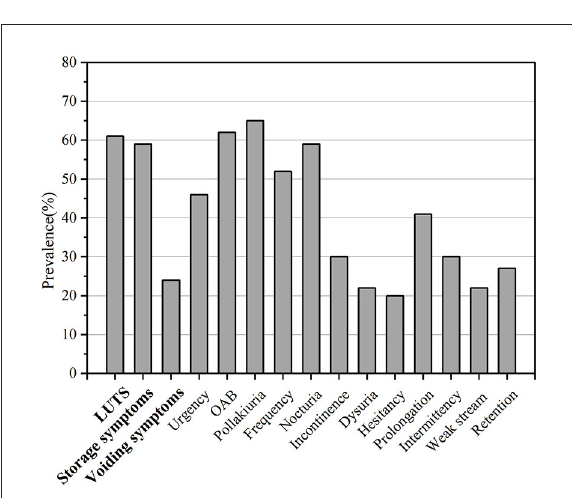
FIGURE3 Frequency of LUTS or its subtypes in PD patients. The x-axis shows different kinds of LUTS while the y-axis shows the